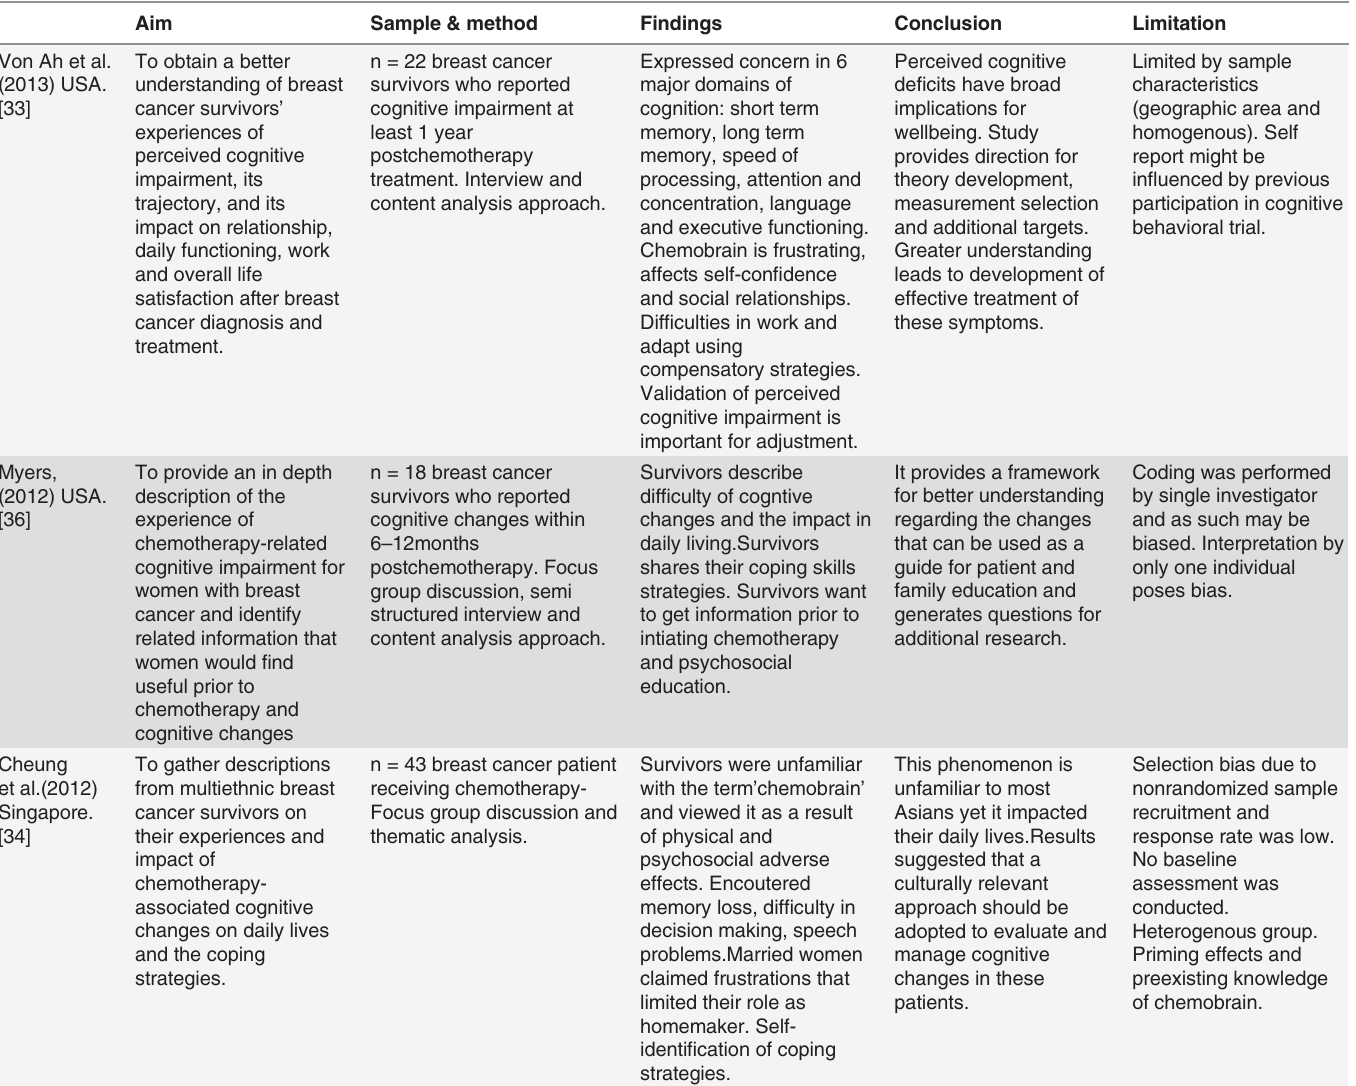
Table 3. Characteristics of the selected